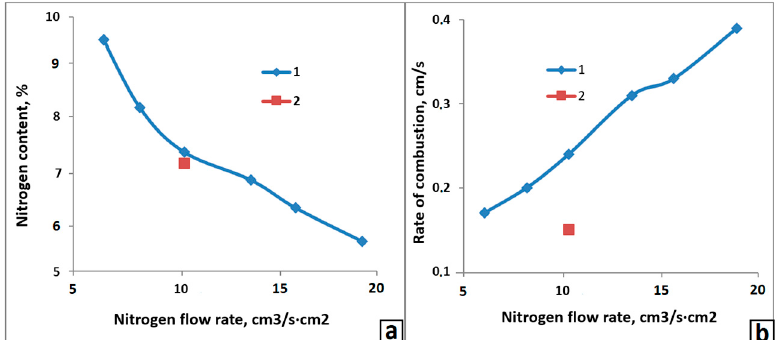
Figure 13. ( a ) Impact of the specific flow rate of nitrogen on the combustion rate, and ( b ) degree of nitridation of chromium. 1—combustion in nitrogen, 2—combustion in the mixture of nitrogen and 3—argon.